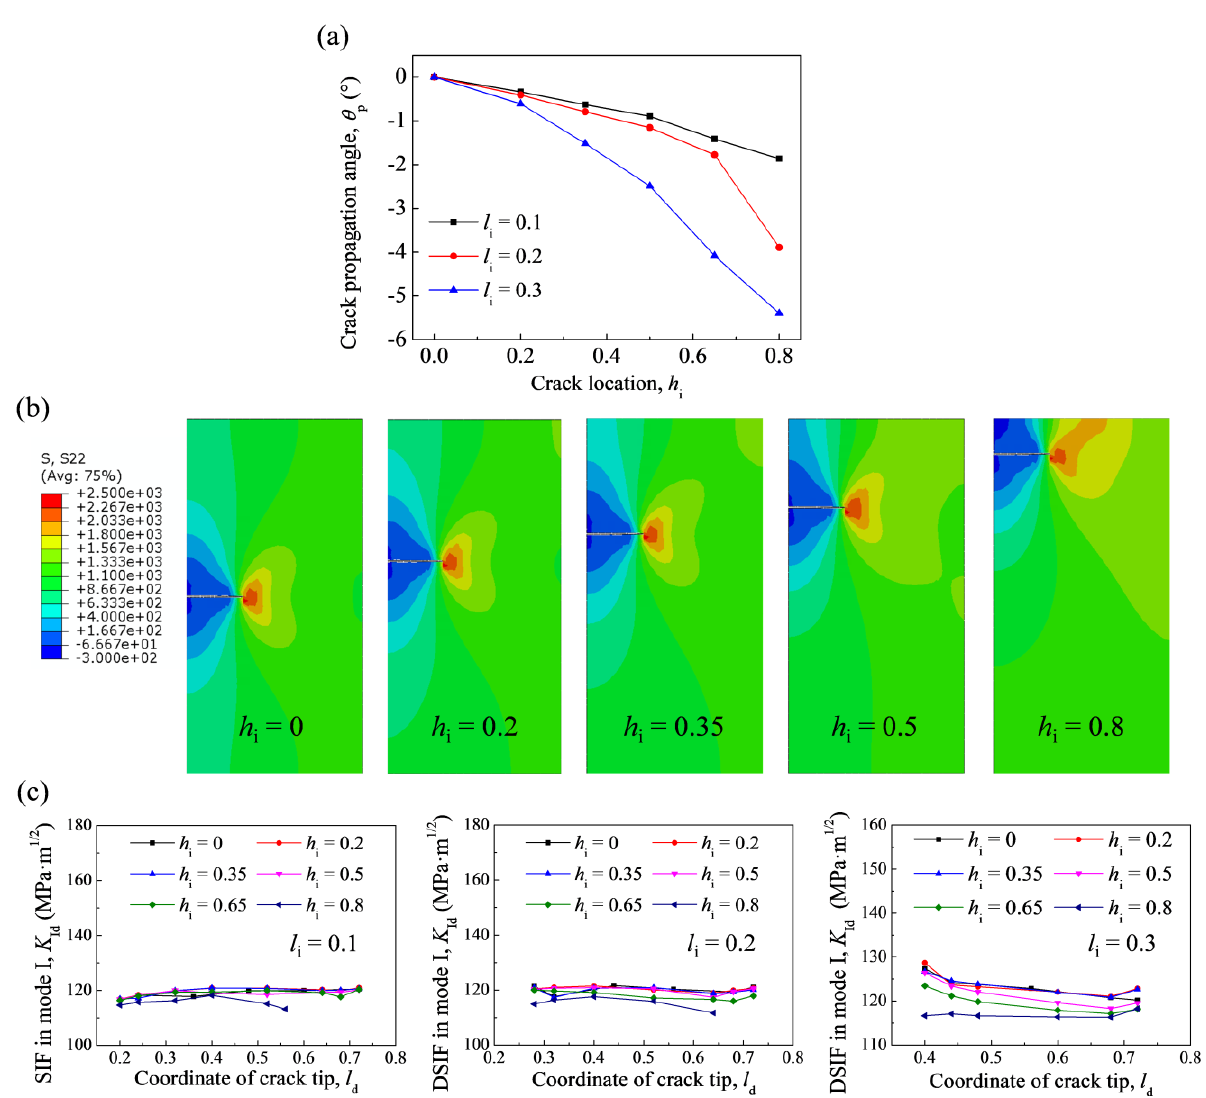
Figure 9. Comparison of ( a ) crack propagation angles when the crack locations range from 0 to 0.8 and ( b ) stress contours with initial crack length 0.3; ( c ) Comparison of K Id at the initial crack locations ranging from 0 to 0.8 and the initial crack lengths ranging from 0.1 to 0.3.